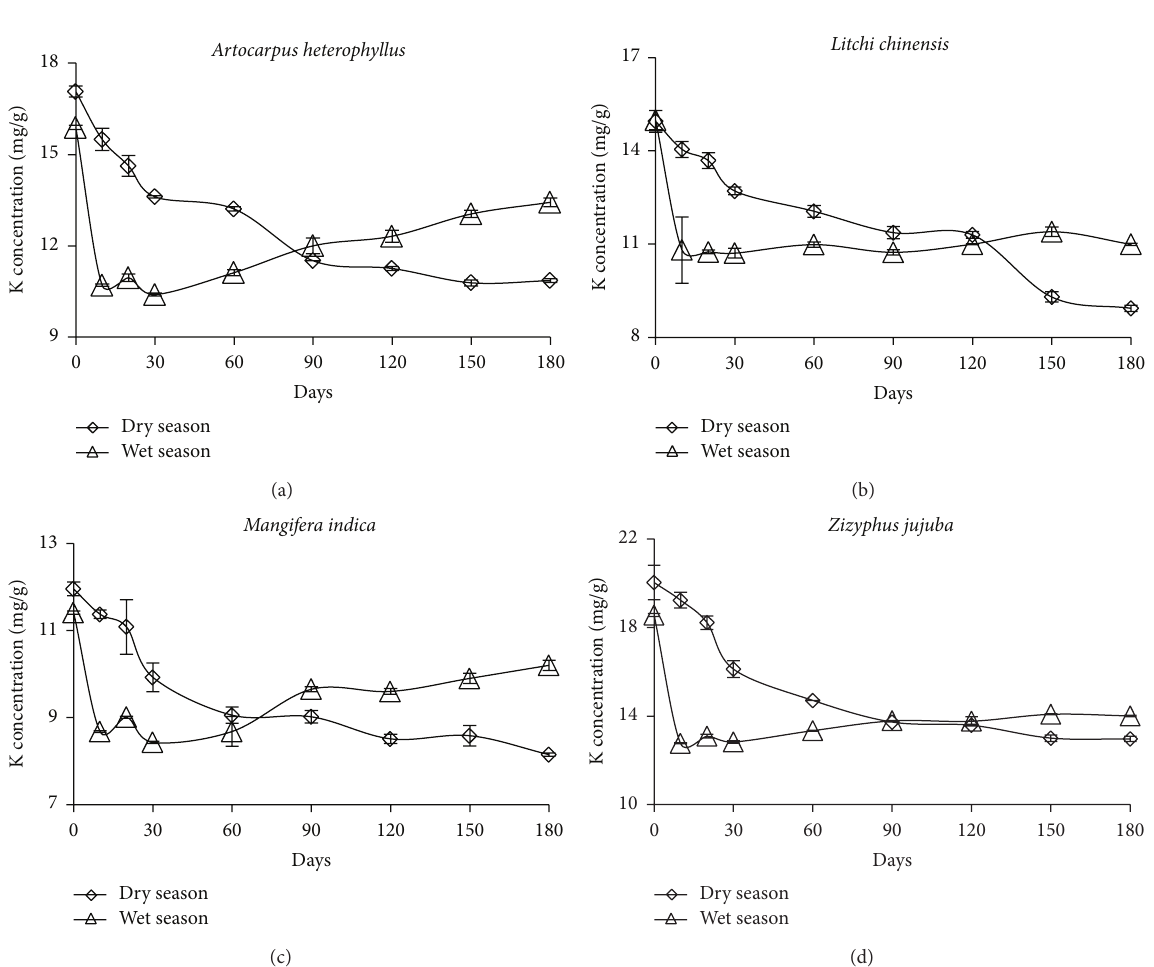
Figure 5: K concentration (mg/g) of leaf litter of four tree species used in agroforestry during the dry and wet seasons over 180-day periods due to microbial